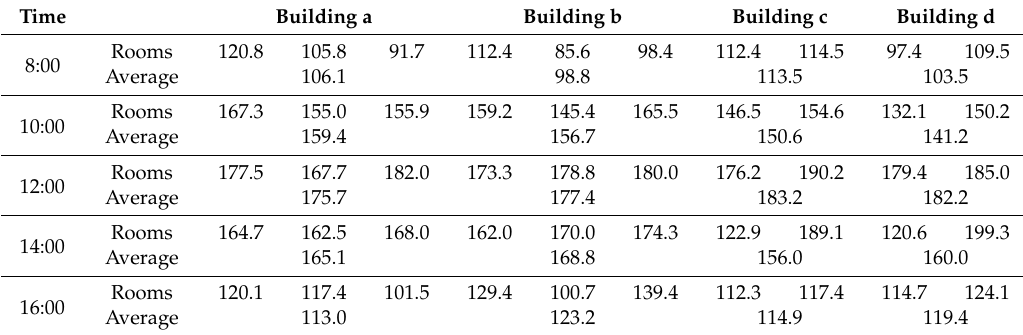
Table 4. Indoor illumination intensity at different times (unit: lux).